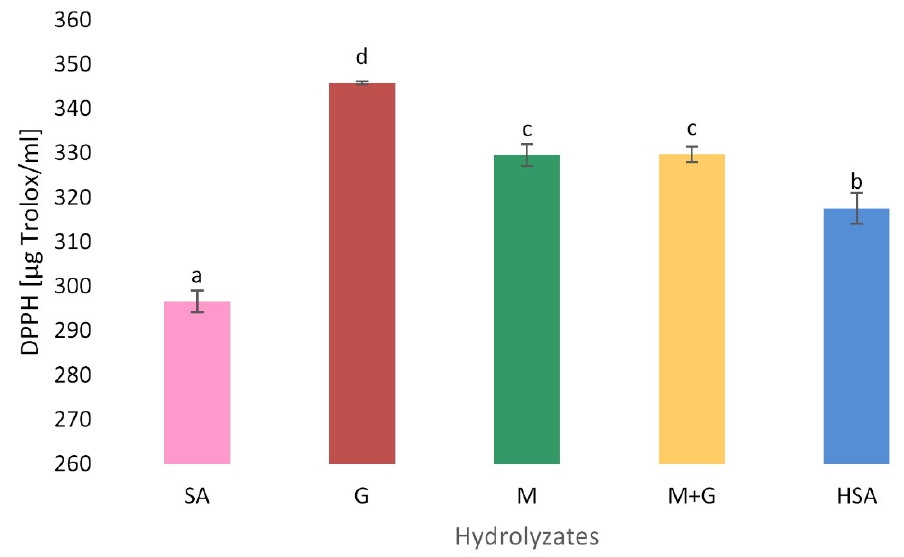
Figure 5. Free radical scavenging activity of acidic (G, M and M + G) and oxidation (HSA) depoly- merization products of sodium alginate (SA). Results are expressed as the mean ± standard error. Values with different letters (a–d) within the same column differ significantly ( p < 0.05).